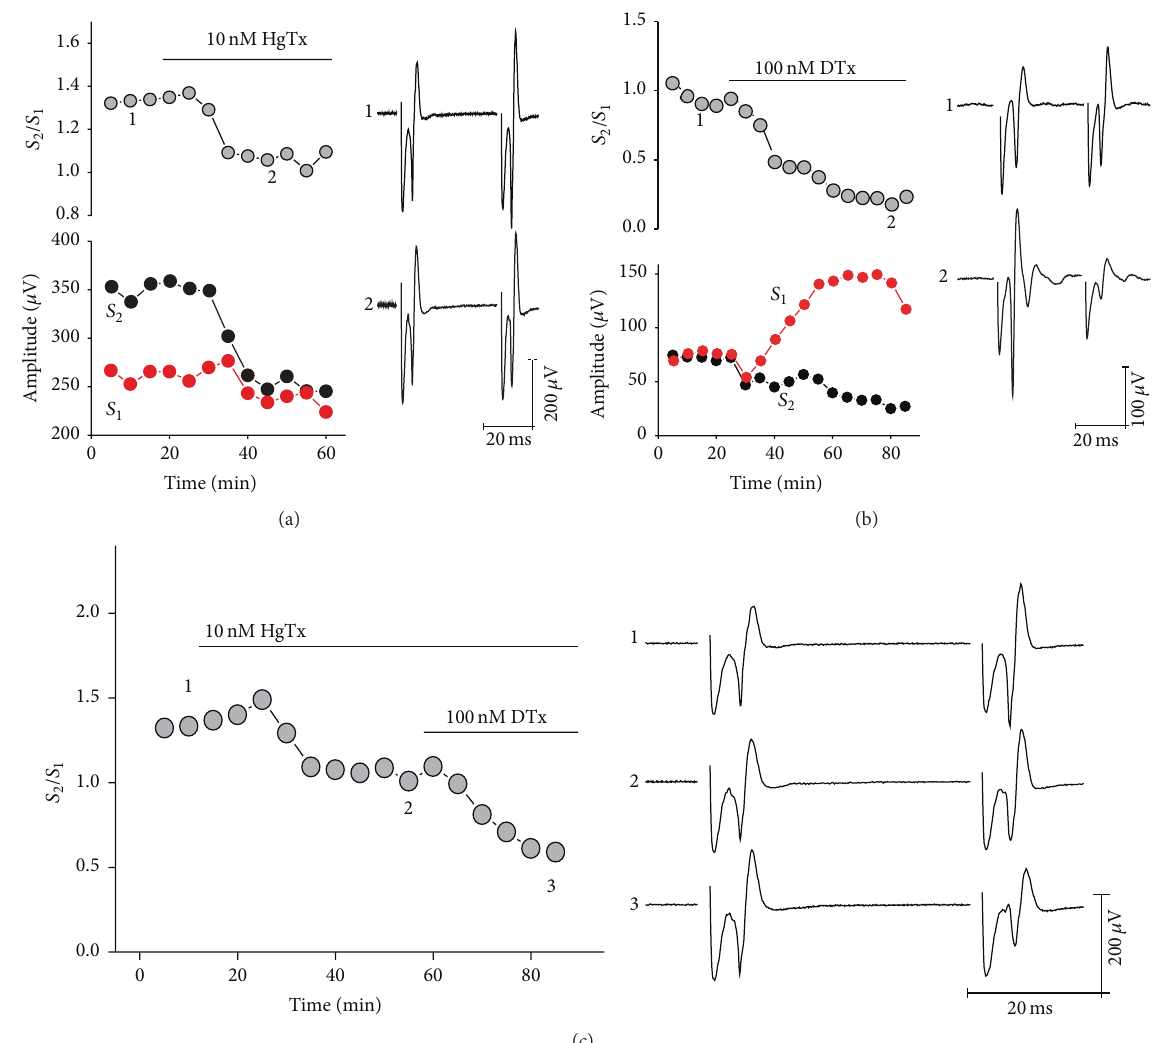
Figure 5: Specific blockers reveal the presence of presynaptic K V 1.6 family potassium channels at corticostriatal synapses. Representative experiments showing the reduction of PPR after exposure to hongotoxin (a) and dendrotoxin (b) alone or applied sequentially (c). In (a) and (b) upper left panels show the time course of PPR as it changes due to drug administration. Horizontal bars indicate time of drug perfusion. Representative traces showing population spikes before (1) and after (2) exposure to drugs are shown in the right panels. The changes in 𝑆 1 (red) or 𝑆 2 (black) amplitude are shown on the left lower panels. Initially PPR was adjusted to obtain PPR ≥ 1. In (c), left panel shows the effect on PPR of adding hongotoxin and dendrotoxin sequentially, and traces on the left are shown to exemplify the reduction of